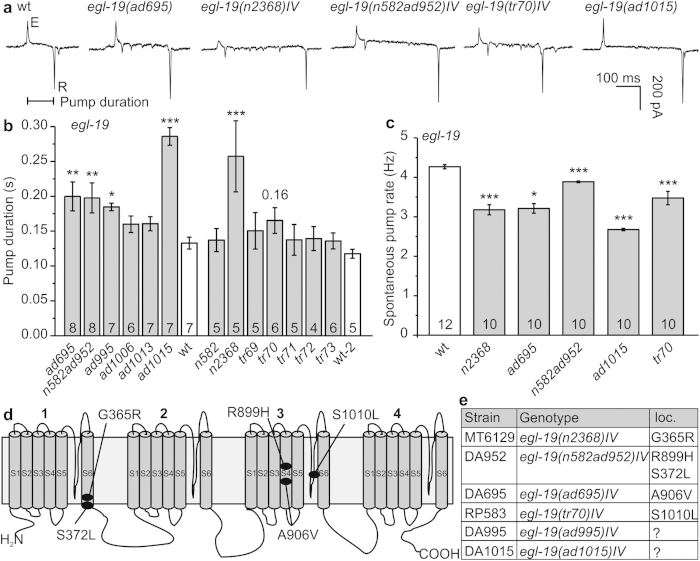
Mutations in the Cav1.2 homolog EGL-19 prolong spontaneous pump duration and reduce pump rate. (a) Original EPG recordings of wild type (wt) and egl-19 mutants (alleles are indicated) with prolonged pump duration (interval E-R spike is indicated). (b) Group data, pump durations (mean ± s.e.m.) during spontaneous pumping, of several egl-19 alleles; statistically significant differences to wt are indicated (***P < 0.001; **P < 0.01; *P < 0.05; one way ANOVA with Fisher post-hoc test). (c) Group data, spontaneous pump rate on food of selected egl-19 mutants, compared to wt (t-test with Bonferroni correction: ***P < 0.001; **P < 0.01; *P < 0.05). (d) Schematic of the EGL-19 α1 subunit of the L-type VGCC with the amino acid changes in the alleles listed in (e).